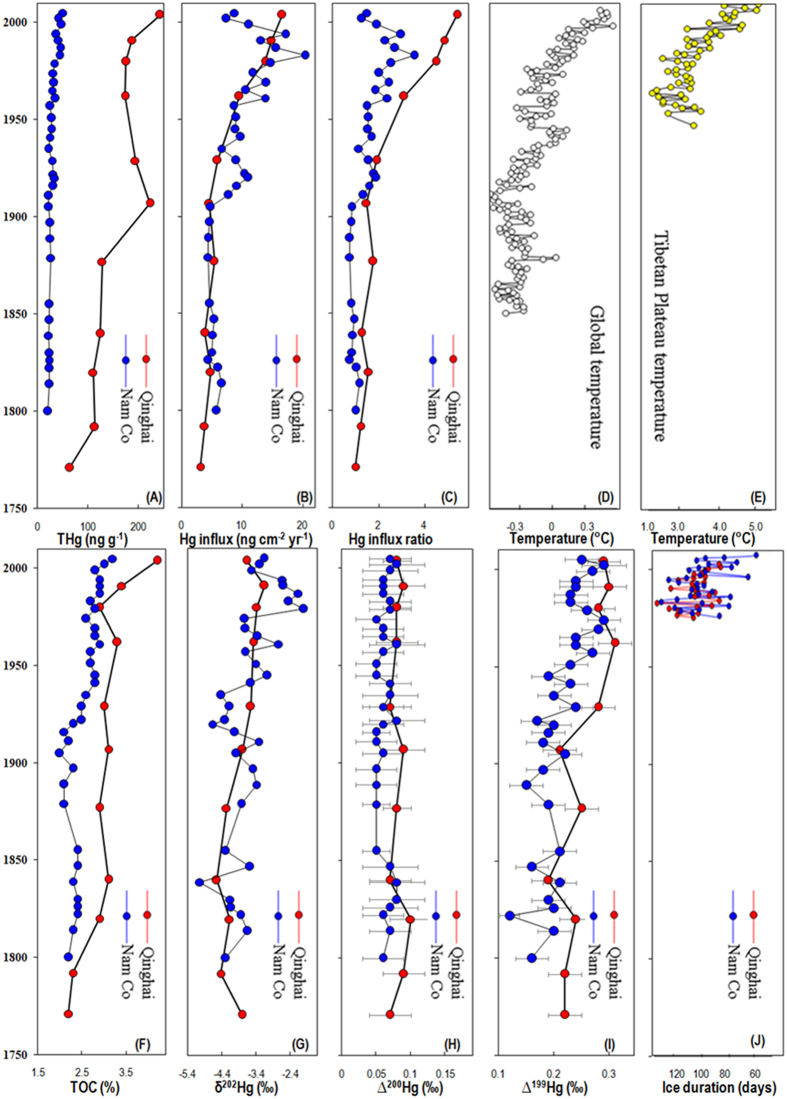
Sediment profiles of THg (A), Hg influx (B), Hg influx ratio (C), global average temperature anomaly ((D) according to Hansen et al.30) and temperature in TP ((E), according to Zhang et al.13), TOC ((F) according to Lami et al.20 and Li et al.22), δ 202Hg (G), ∆ 200Hg (H), ∆ 199Hg (I) and ice duration ((J) according to Che et al.19 and Ke et al.21) in Lake Qinghai and Nam Co.